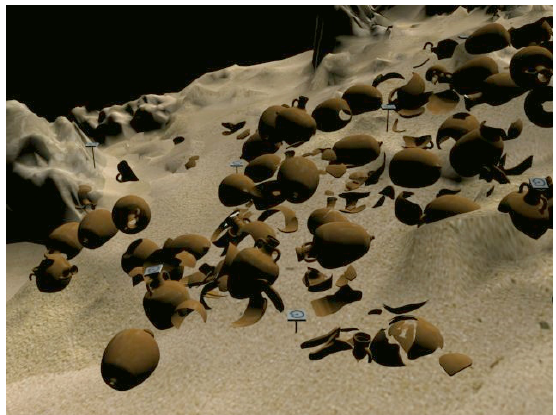
Figure 2: 3D rendered model of wreck No. 6, 3DS